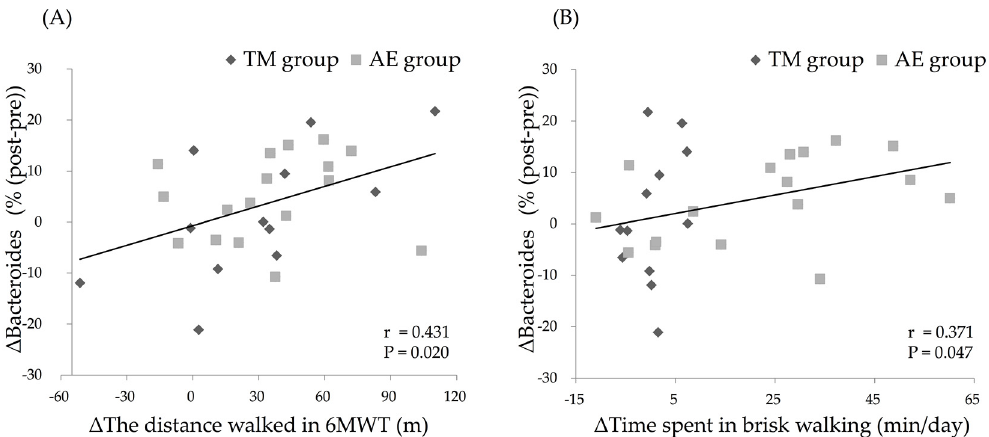
Figure 4. Relationship between changes in the distance during the 6MWT (6MWD) ( A ), changes in the time spent in brisk walking ( B ), and changes in the relative abundance of intestinal Bacteroides by the intervention. Improvements in 6MWD and time spent in brisk walking were positively correlated with increases in the relative abundance of intestinal Bacteroides in all subjects. Abbreviations: TM, trunk muscle training; AE, aerobic exercise training; 6MWT, 6-min. walk test; 6MWD, distance in the